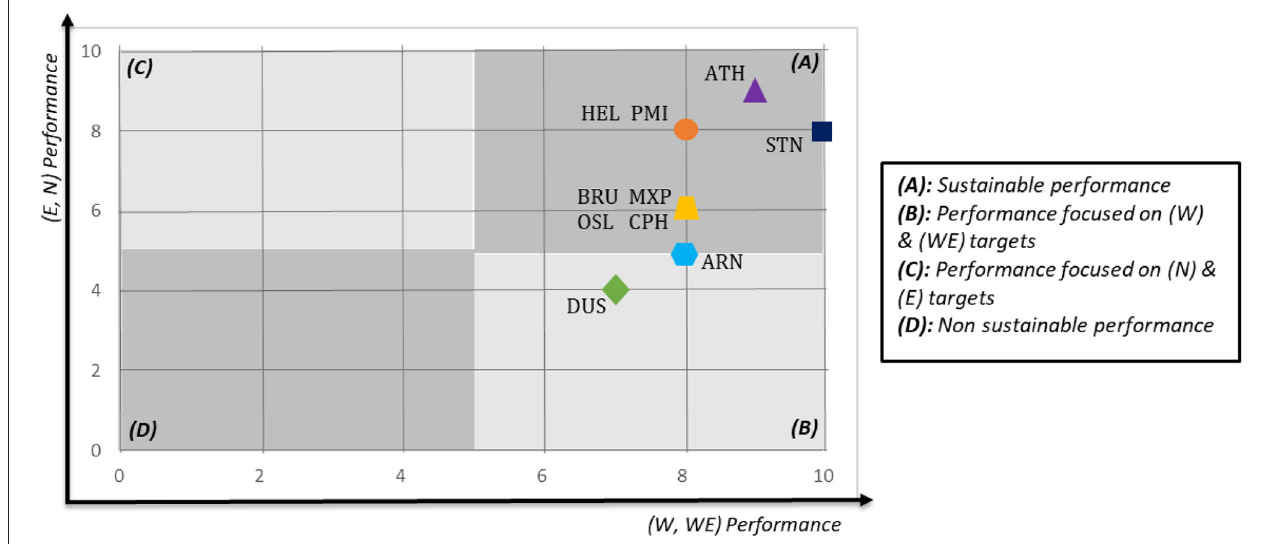
FIGURE 4 | Depiction of airports’ environmental performance aggregated